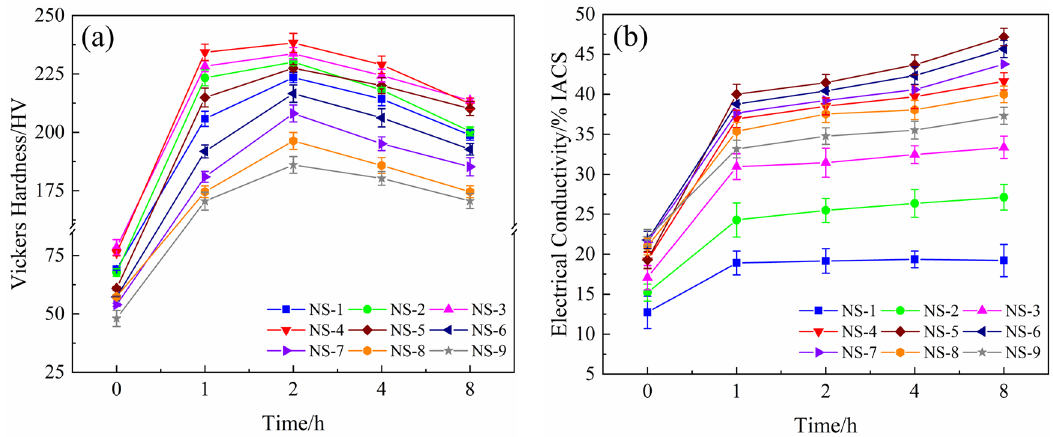
Figure 1. Hardness and electrical conductivity of alloys with different Ni/Si mass ratios. ( a ) Hardness and ( b ) electrical conductivity.